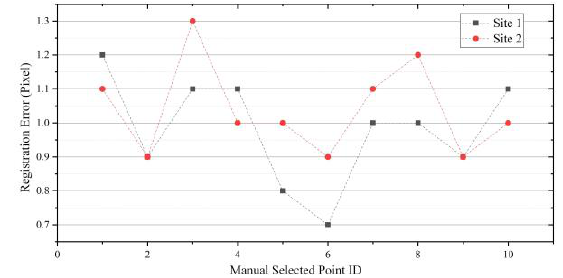
Fig.6 Error distribution of the manual selected points.